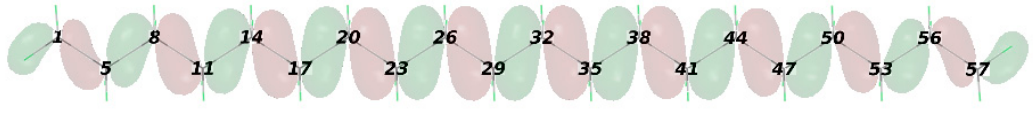
Figure 3. Isosurface of HOMO of eicosane molecule.